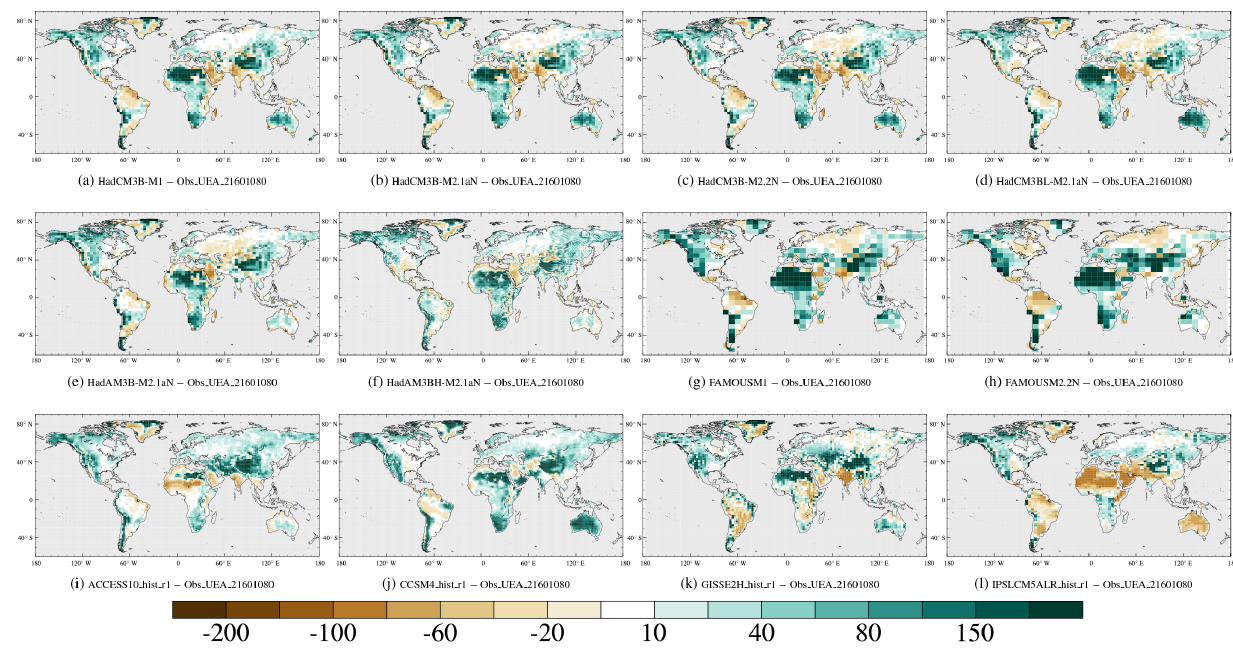
Figure 4. As for Fig. 3 but showing the difference in mean annual precipitation, expressed as a % difference to the CRU CL v2.0 observations.